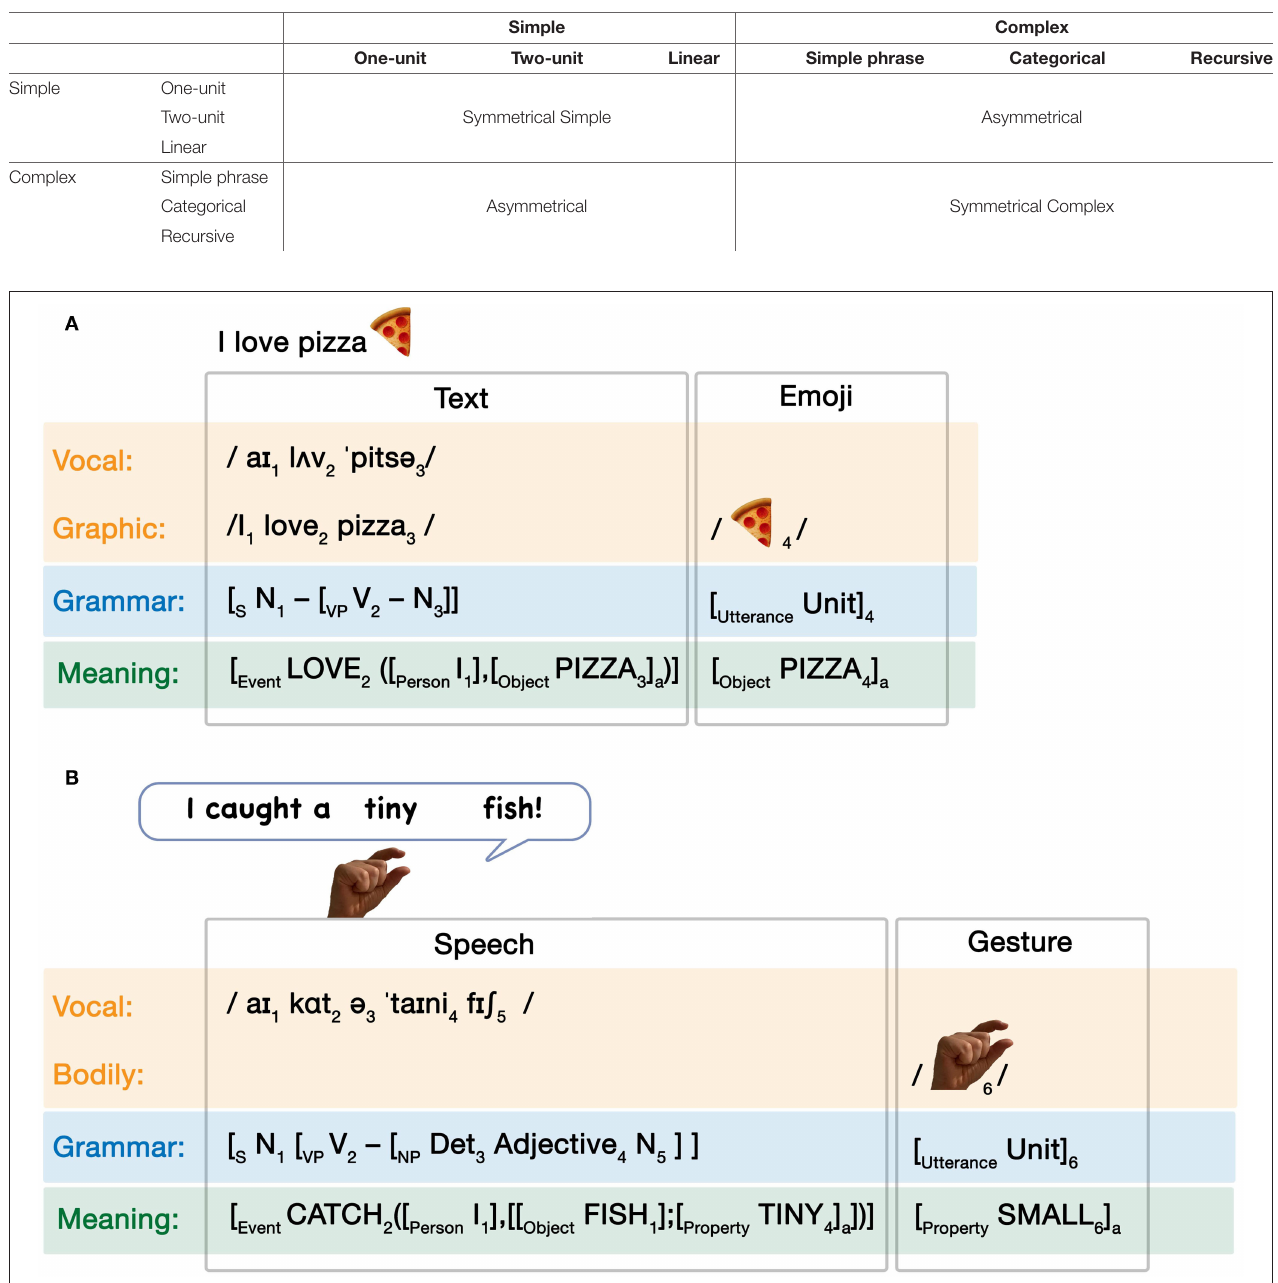
FIGURE 6 | Independent grammatical interactions between (A) text and emoji and (B) speech and